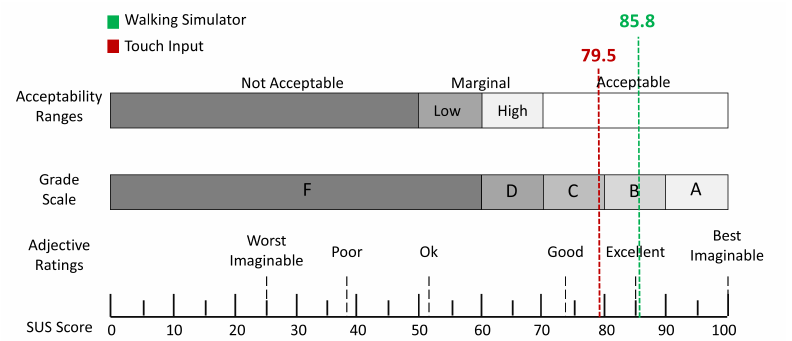
Figure 8. SUS scores for walking simulator-based movement and touch input-based movement [45].